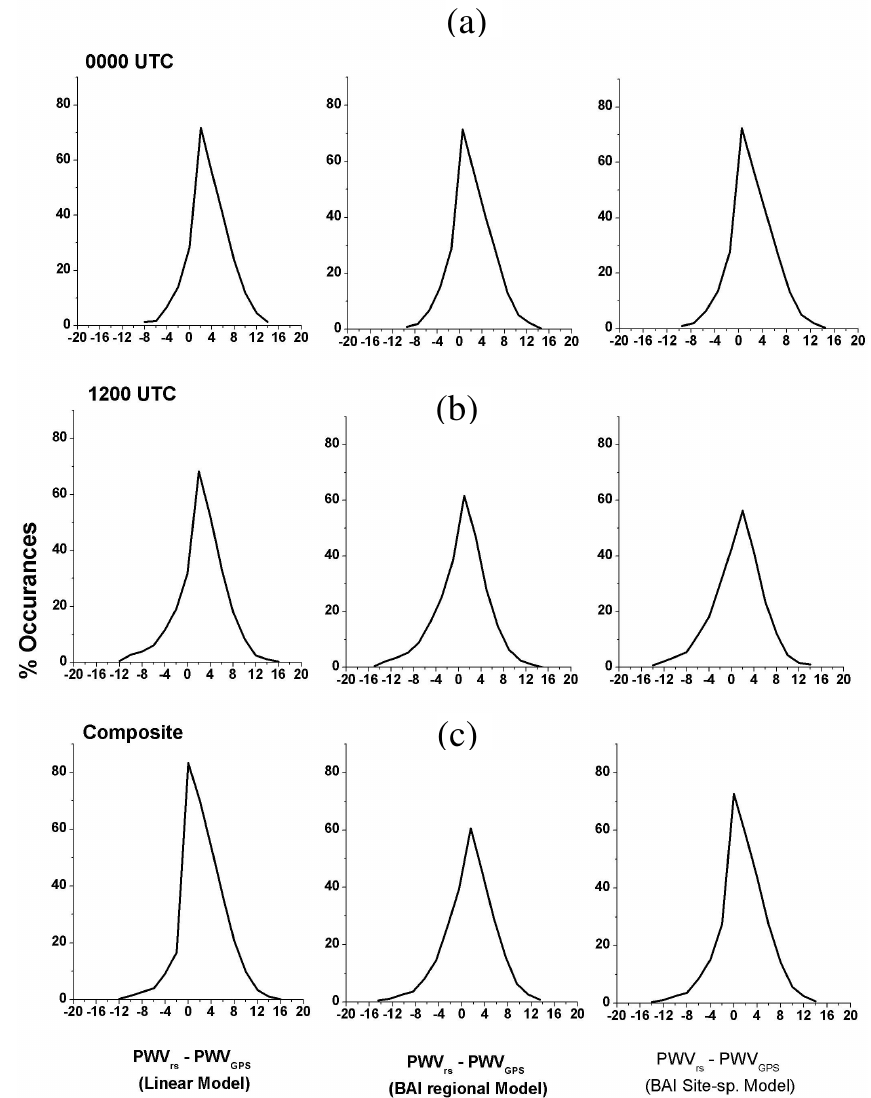
Fig. 10. Cumulative percentage (number of occurrences above a particular value in the case of positive deviations and number of occurrences below a particular value in the case of negative deviations) distribution of the deviations shown on different panels of Fig. 8a after accounting for the height correction in water vapor profile at 00:00 UTC (a) , 12:00 UTC (b) and combining both 00:00 and 12:00 UTC (c)